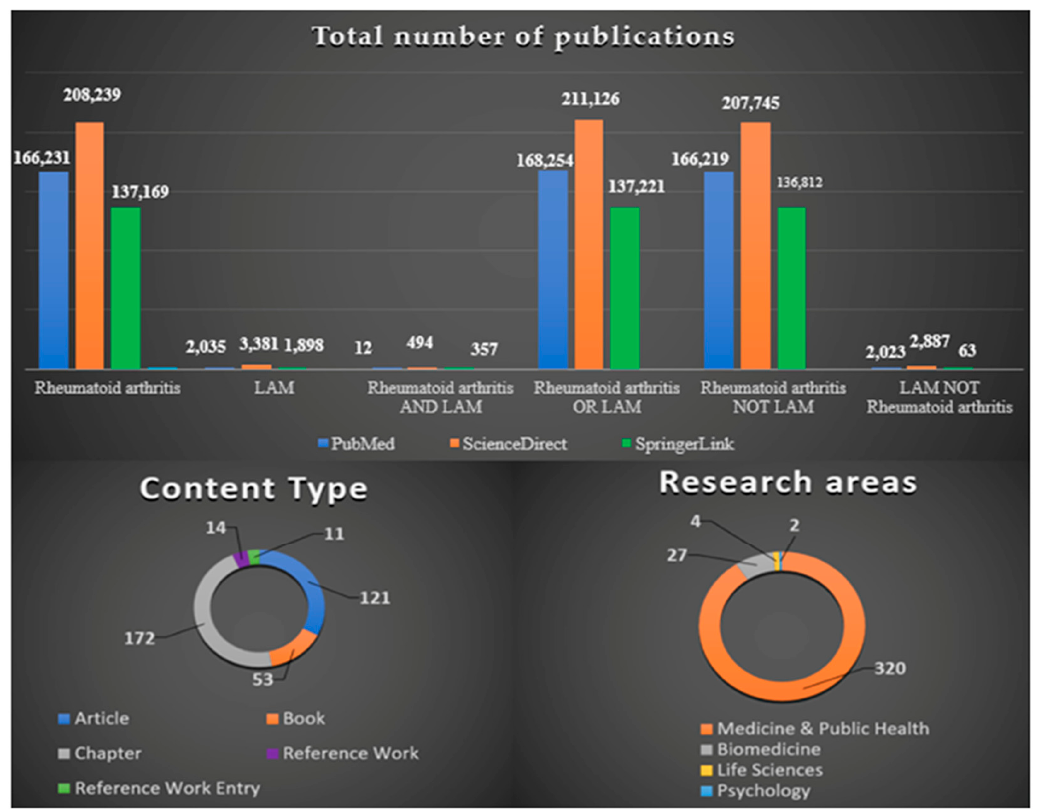
Figure 1. Literature impact on the RA-LAM association and relevant study areas and publication varieties highlighted via Boolean search tools in large databases. RA, rheumatoid arthritis; LAM, lymphangioleiomyomatosis.